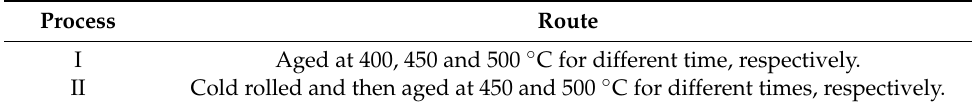
Table 1. Two kinds of thermo-mechanical treatment processes. Process Route